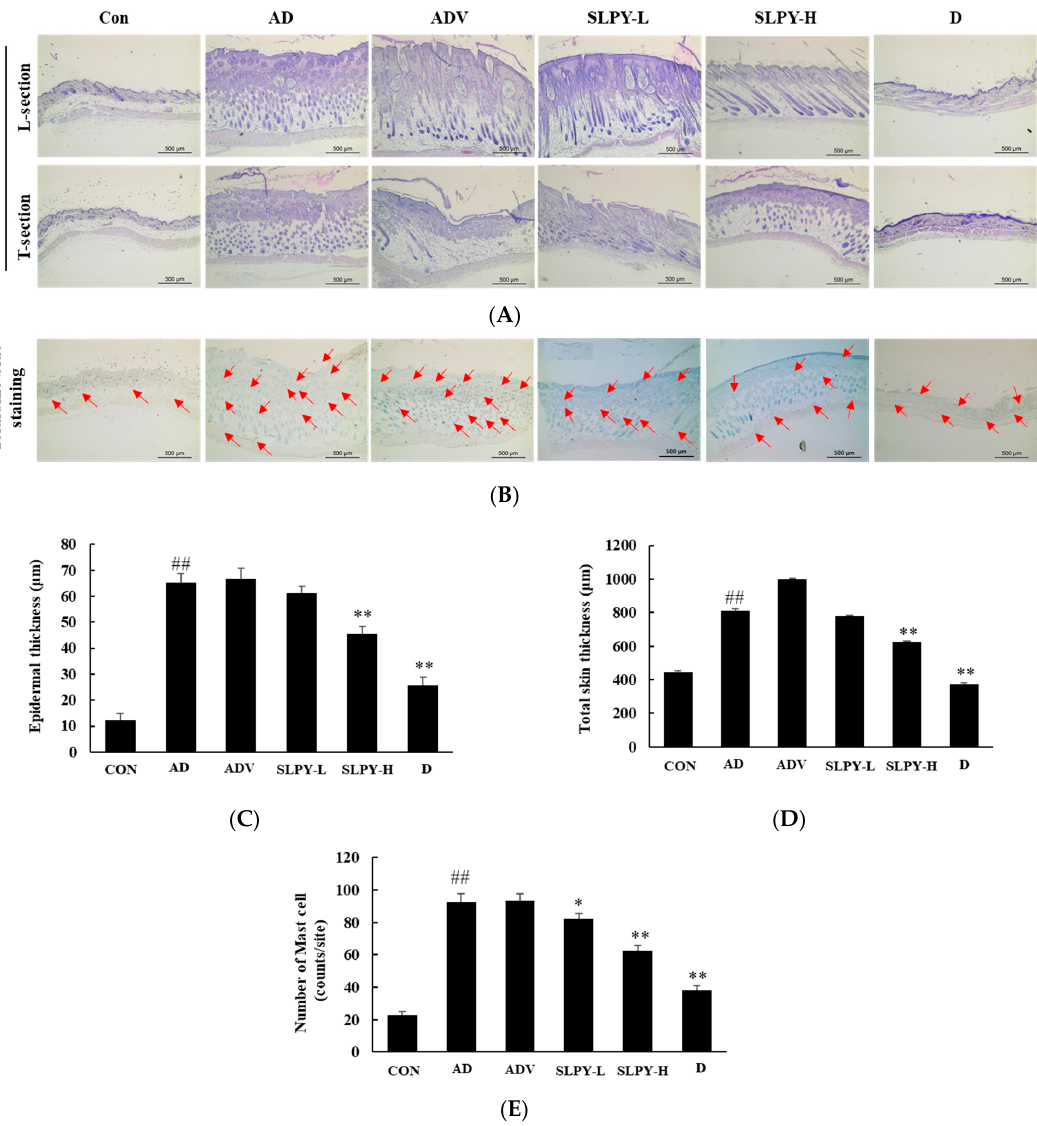
Figure 7. Effect of topical application of SLPY by-product on the histological features of dorsal skin of DNCB-treated AD mice. ( A ) Representative photographs of hematoxylin and eosin (H&E)- stained skin tissues isolated from SLPY-treated AD mice at × 50 magnification (scale bar: 500 µ m). ( B ) Representative photographs of toluidine blue-stained dorsal skin tissues of SLPY-treated AD mice at × 50 magnification (scale bar: 500 µ m). ( C ) Epidermal thickness of DNCB-treated BALB/c mice tested with SLPY against control and Dermatop. ( D ) Total skin thickness of DNCB-treated BALB/c mice tested with SLPY against the control and Dermatop. ( E ) Mast cell number of DNCB-treated BALB/c mice tested with SLPY against the control and Dermatop. Red arrows pinpoint the mast cells present in the toluidine blue-stained dorsal skin tissues. Data represented as mean ± SD of at least three replicates. Significant differences in each treatment group indicated based on Dunnett’s multiple comparison post hoc analysis. ## p < 0.01 vs. the corresponding control group and ** p < 0.01, * p < 0.05 vs. the corresponding AD group. CON: non-treatment group; AD: 2,4-dinitrochlorobenzene (DNCB)- induced group; ADV: combined treatment of 1% DNCB and vehicle; SLPY-L: combined treatment of 1% DNCB and 50 mg/Kg SLPY; SLPY-H: combined treatment of 1% DNCB and 100 mg/Kg SLPY; D: combined treatment of 1% DNCB and Dermatop (0.25% w/w